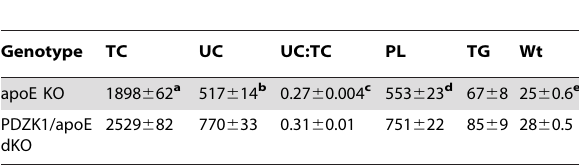
Table 1. Plasma lipid levels and body weights of apoE KO and PDZK1/apoE dKO